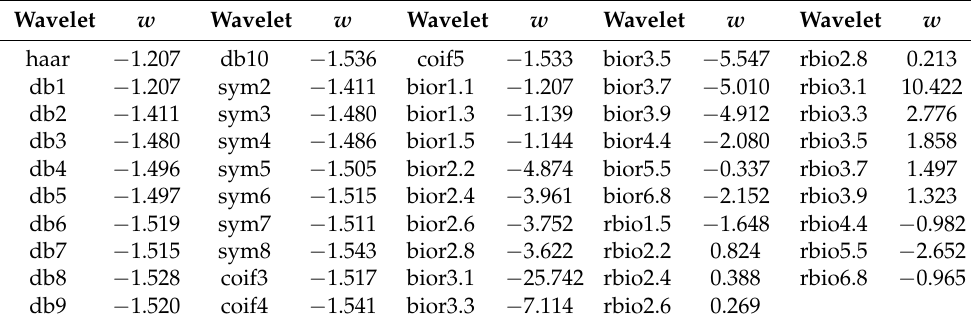
Table 4. The decomposition stability w of each wavelet concerning M 2